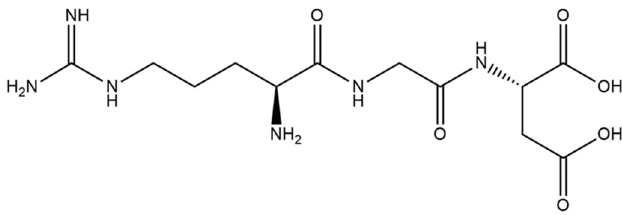
Figure 12. Schematic representation of the RGD peptide’s chemical structure.